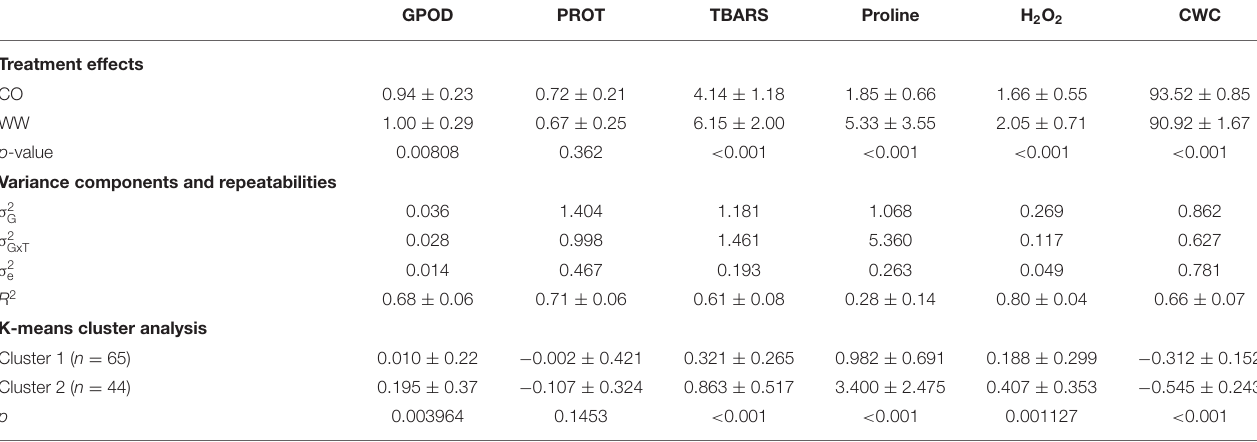
TABLE 1 | Mean values ± standard deviations and p -values of differences in means in control (CO) and 10-day water withholding treatment (WW) for GPOD (AU/g FW) PROT (mg/g FW), TBARS (ng/g FW), proline (nmol/mg FW), H 2 O 2 (nmol/g FW), and CWC (%) followed by variance components and repeatabilities ± standard errors of repeatabilities and the results of K-means clustering analysis with cluster means of trait fold-change and the accompanying p -values of pairwise t -tests between cluster means.